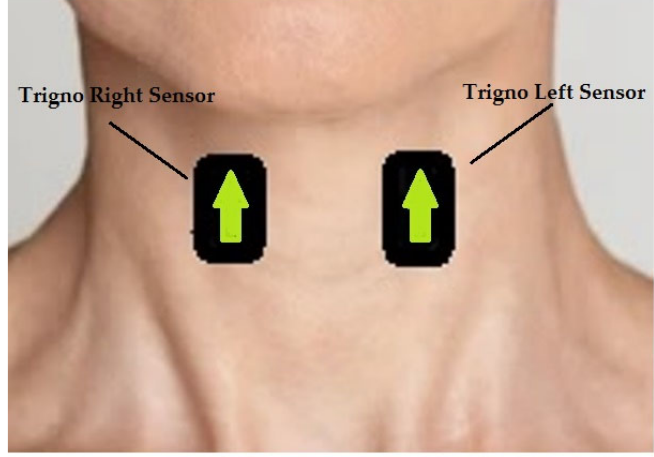
Figure 1. The figure shows the anatomical position on which sensors were placed. The arrows indicate the use of Delsys trigno system.